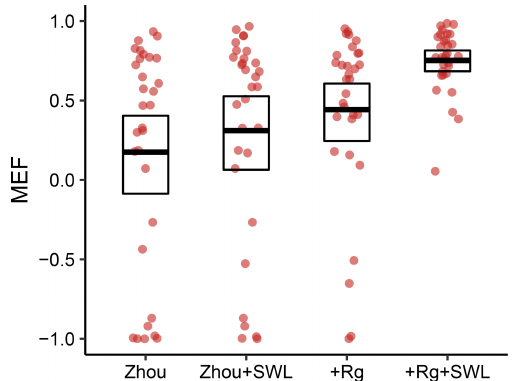
Figure 6. Model performance of the two original models and their amended variants which include an attenuation function reflecting soil-water availability. The models were evaluated during dry-down events. The dots denote individual sites. The bold line denotes the mean for all sites, while the box represents the 95% confidence intervals of the